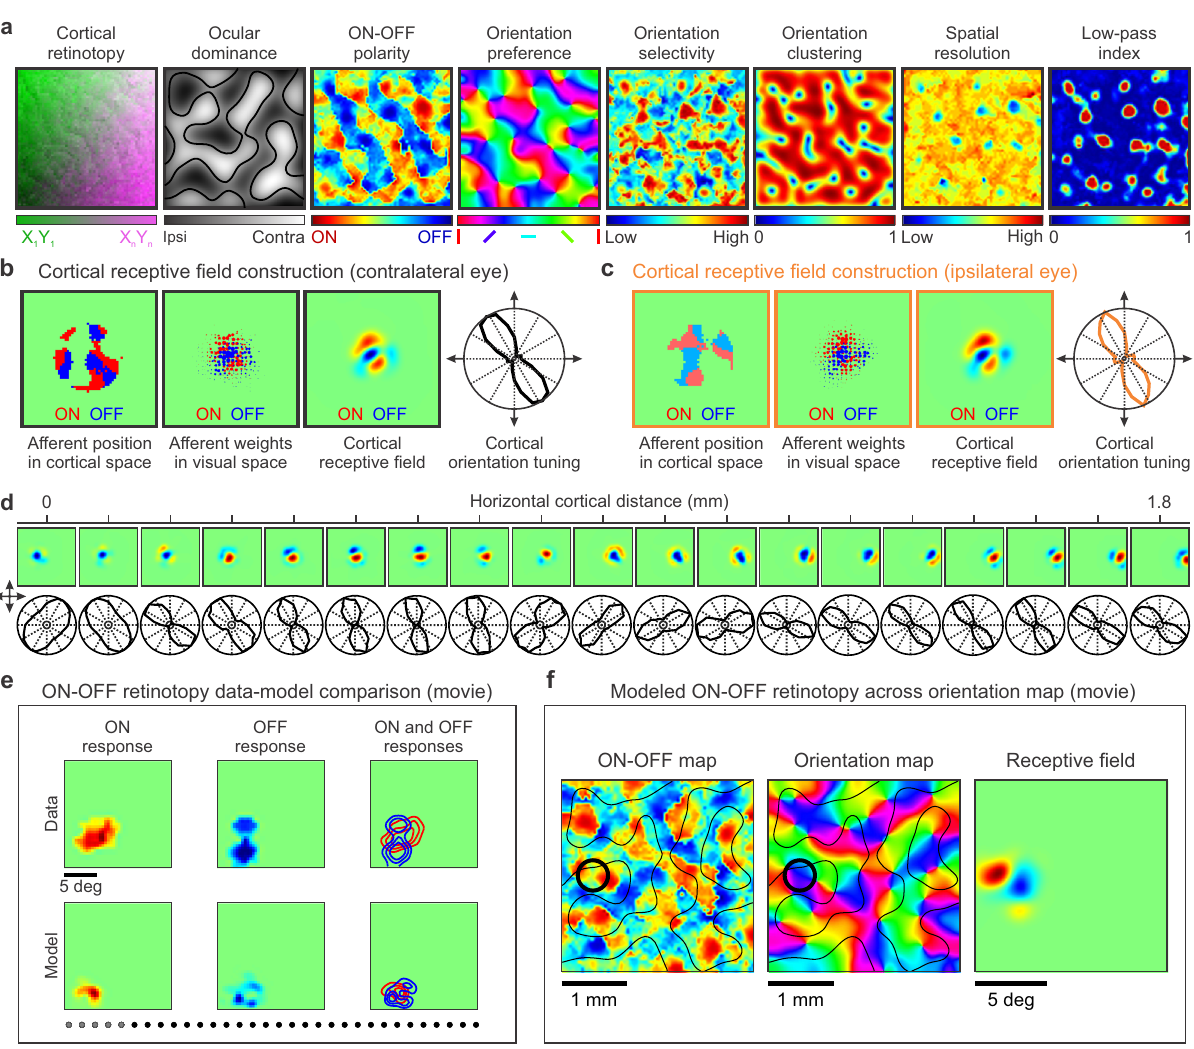
Fig. 6 Model outputs. Visual maps for multiple stimulus dimensions, cortical receptive fi elds and neuronal response properties. a The model generates maps for multiple stimulus dimensions illustrated, from left to right, for retinotopy, ocular dominance, ONOFF polarity, orientation preference, orientation selectivity, orientation clustering, spatial resolution (highest spatial frequency generating half-maximum response), and low-pass index (response at lowest spatial frequency divided by maximum response). b The model output also provides the position in cortical space of the main afferent axons converging at the same cortical pixel (left square panel), the afferent receptive fi eld positions and synaptic weights in visual space (middle square panel, dot position and size), and the cortical receptive fi eld and orientation tuning resulting from afferent convergence (for the contralateral eye). c Same as ( b ) for the ipsilateral eye (notice the precise binocular match of orientation preference). d It also generates cortical receptive fi elds (top) and orientation tuning (bottom) for each pixel of the visual map. As in experimental measures 28 , the receptive fi elds change with cortical distance in position (retinotopy), ONOFF dominance, orientation preference, and subregion structure (top). The orientation preference and orientation selectivity also changes systematically with cortical distance (bottom). e Model-data comparison of ON-OFF retinotopy changes with cortical distance (see movie Fig. 6e). The gray dots at the bottom illustrate the cortical pixels included in the receptive fi eld average (average along a cortical distance of 400 microns, distance between pixels 100 microns). Notice that ONOFF retinotopy systematically changes along a diagonal line in visual space. However, the diagonal line is not straight; ON and OFF retinotopy move around and intersect with each other, as expected from ONOFF afferent sorting. f Model simulations illustrating the relation between ONOFF dominance (left), orientation preference (middle), and receptive fi eld structure (right, see movie Fig.